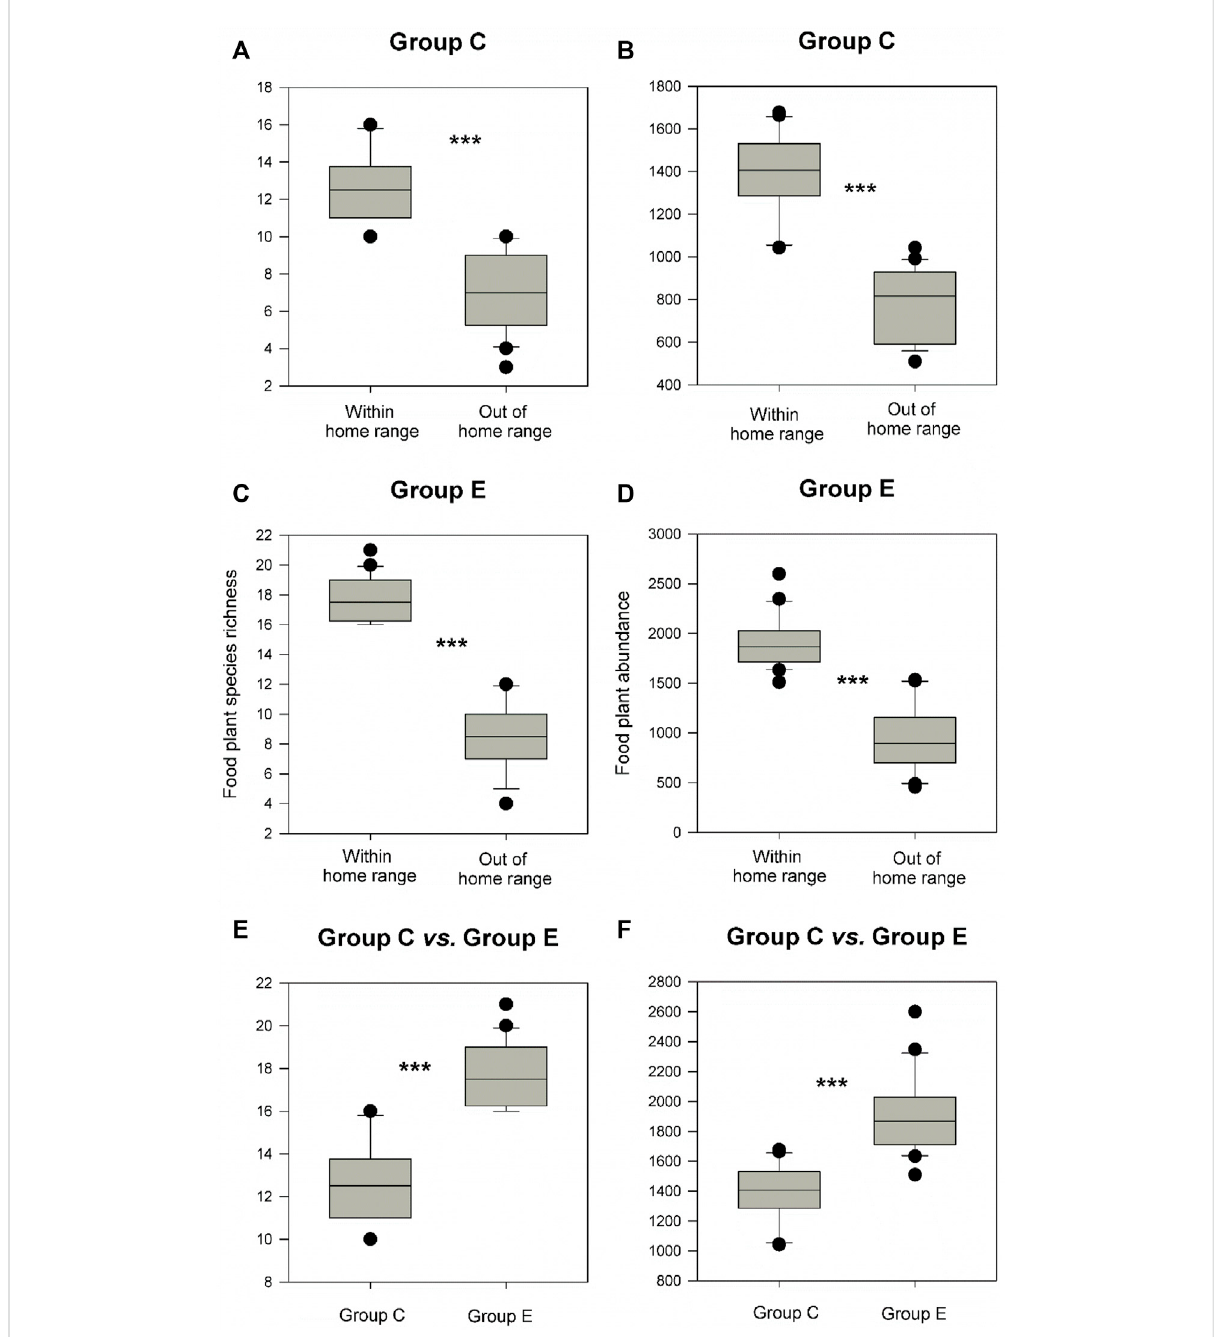
FIGURE 2 Differences in food plant diversity (richness and abundance) between within and out of the home range in groups C and E (A – D) and between the home range of groups C and E (E,F) . Box plots show the median (line within the box), 25th and 75th percentiles (the boundaries of the box), and 90th and 10th percentiles (error bars). *** indicates p < 0.05 and shown are results from Wilcoxon signed rank